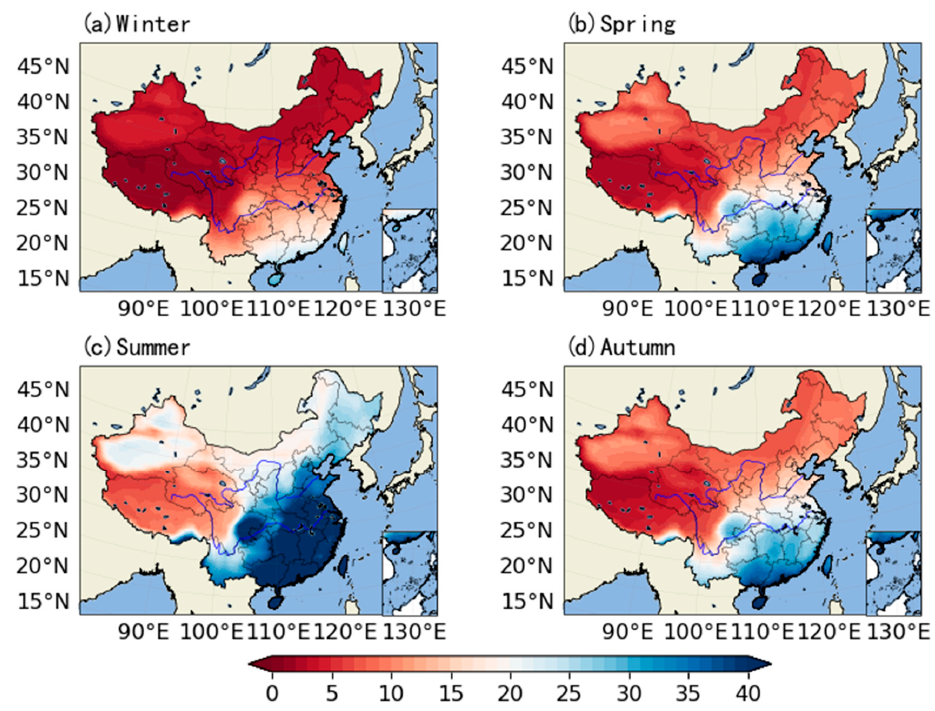
Figure 2. TCWV of China in each season. ( a ) Winter. ( b ) Spring. ( c ) Summer. ( d ) Autumn.